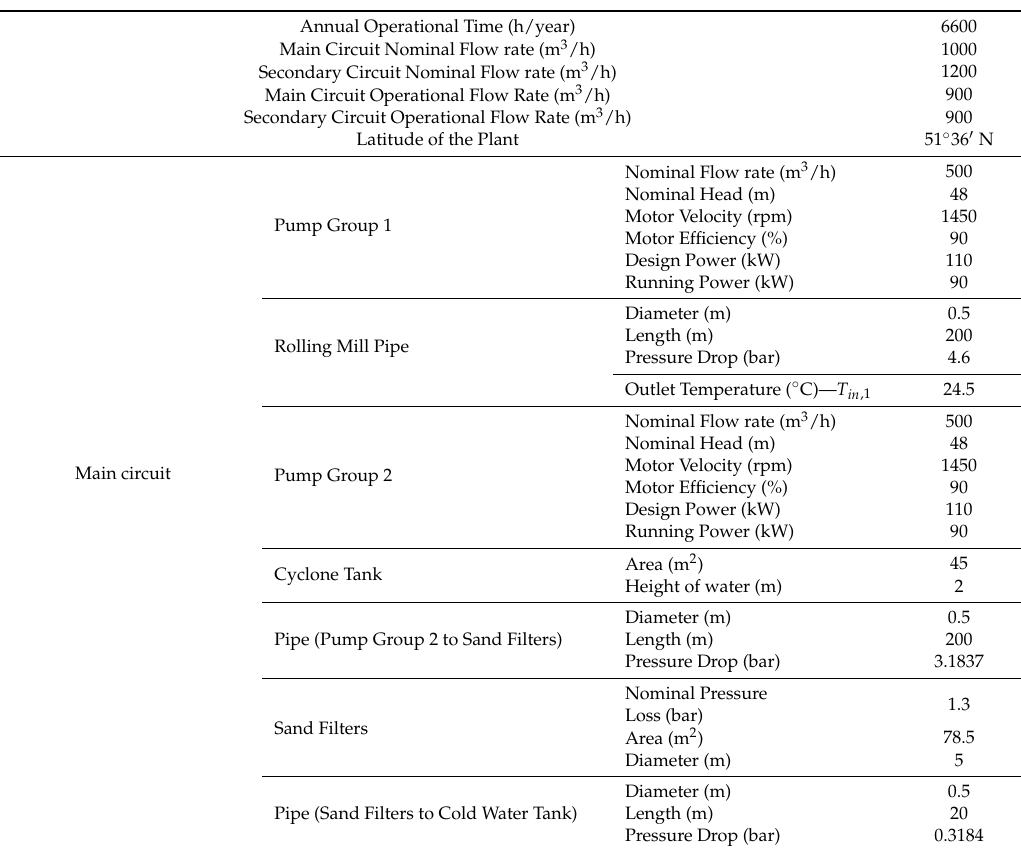
Table 1. Specifications for the assembling of the cooling circuit.